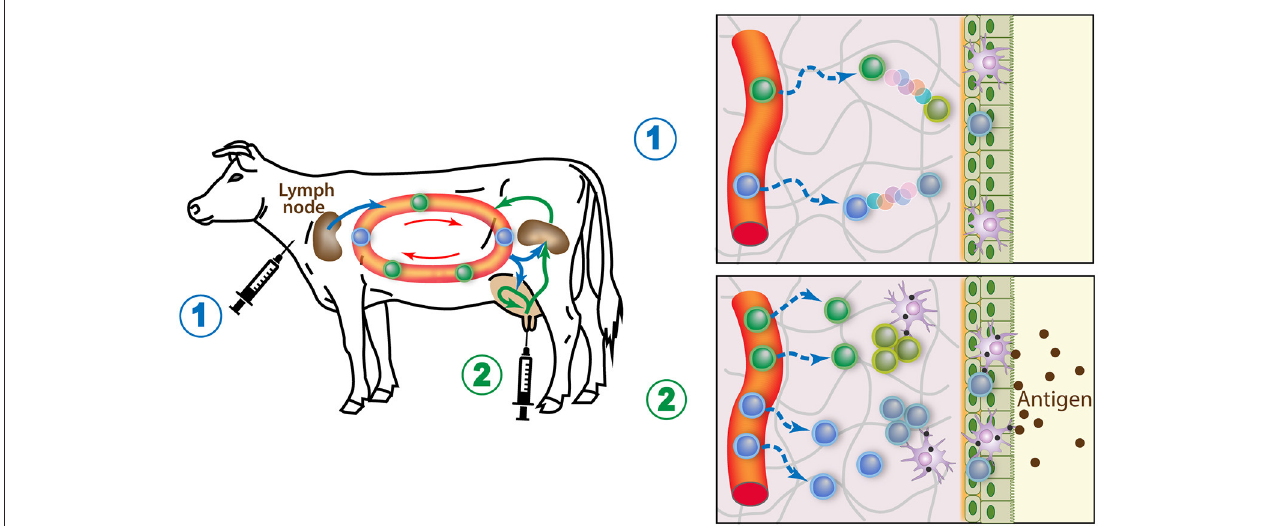
FIGURE 4 | How the prime and pull vaccine strategy would populate the MG with memory lymphocytes. 1) A parenteral immunization (prime) elicits circulating antigen-specific T cells, some of which seed the MG tissue and mature into resident memory T cells. 2) A booster injection of antigen in the gland lumen causes local APCs to stimulate the resident memory T cells cells, which in turn induces an enhanced recruitment of circulating T cells, boosts the systemic immune response, and induces replication of the local Trm cells. These responses maximize the generation of local resident memory T cells.